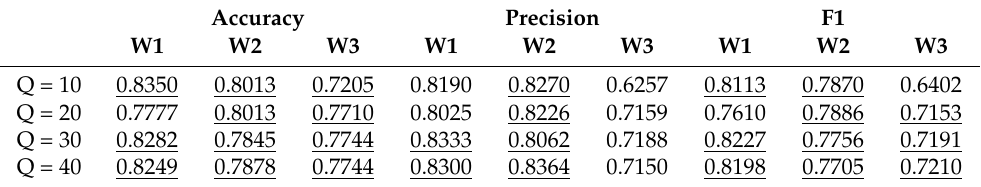
Table 4. Evaluation of W1, W2 and W3’s personalized models generated with 70% AL dataset bias after Q = 10,20,30,40 queries, using their corresponding evaluation datasets. Underlined results mean increased metrics in comparison with the corresponding FL evaluation.